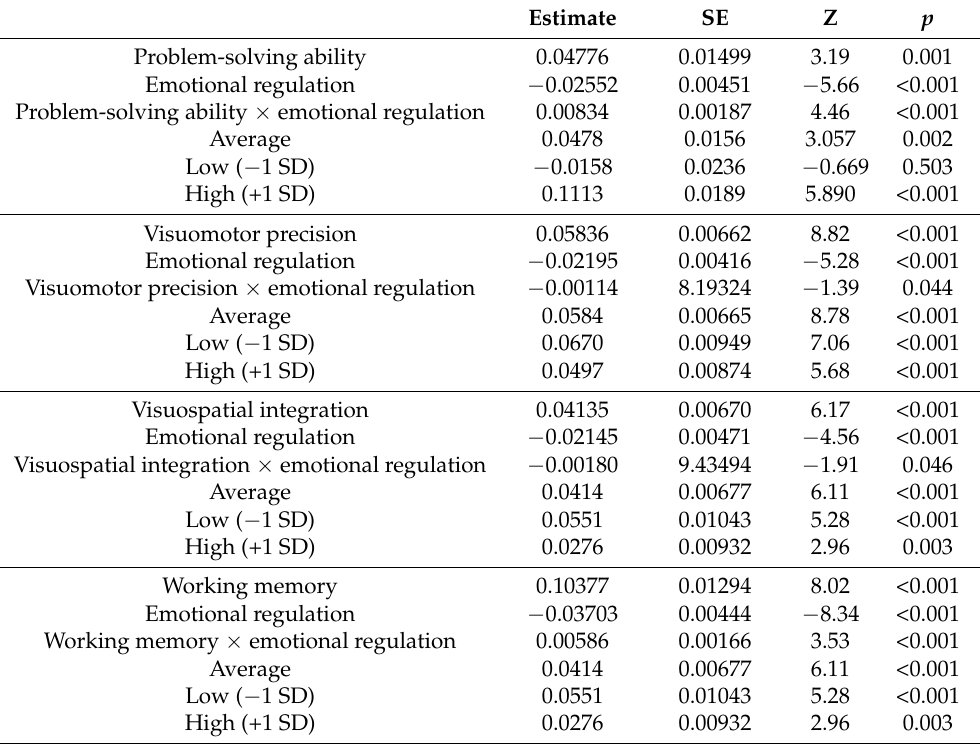
Table 4. The effect of the predictors (problem-solving ability, visuomotor precision, visuomotor integration, working memory) on the dependent variable (school results) at different levels of the moderator (emotional regulation) for the control